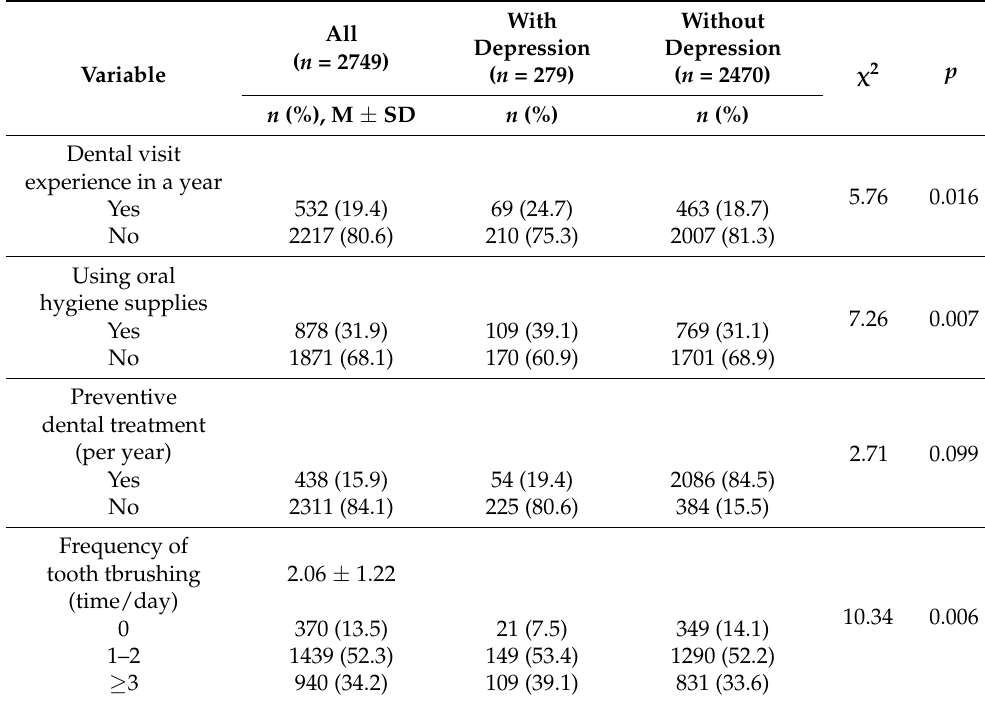
Table 2. Differences in oral health behavior according to the diagnosis of depression ( N =